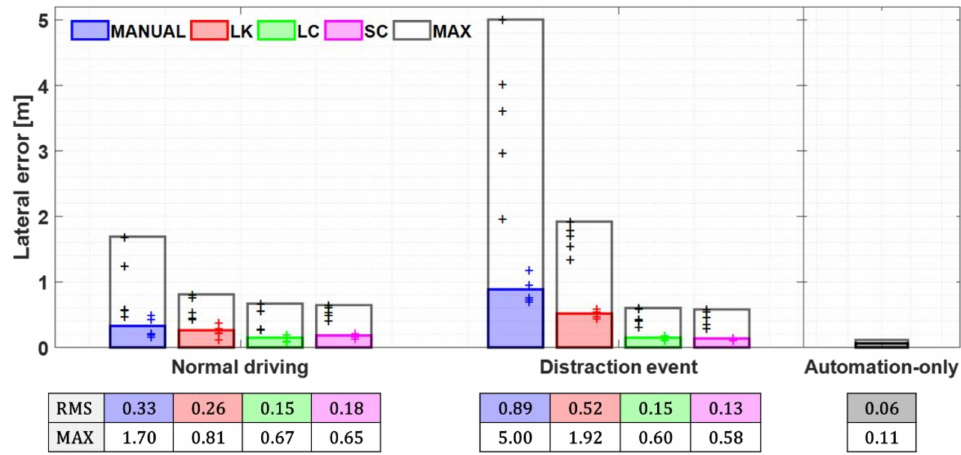
Figure 9. Tracking error statistics (RMS and MAX of lateral error).